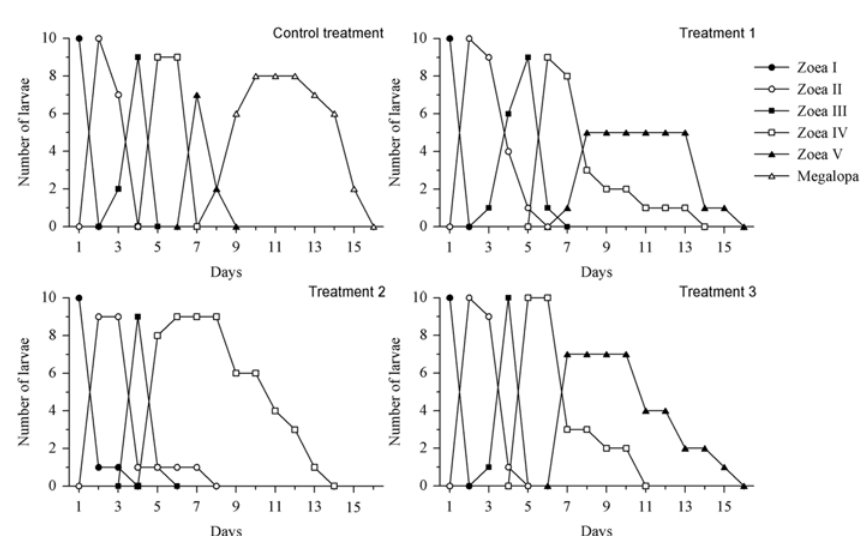
Fig. 1 – Number of surviving larvae of each stage during cultivation of Callichirus major submitted to an initial period of feeding. Control treatment: larvae were fed every day; Treatment 1: larvae were fed for 1 day only; Treatment 2: larvae were fed for 2 days; Treatment 3: larvae were fed for 3 days.